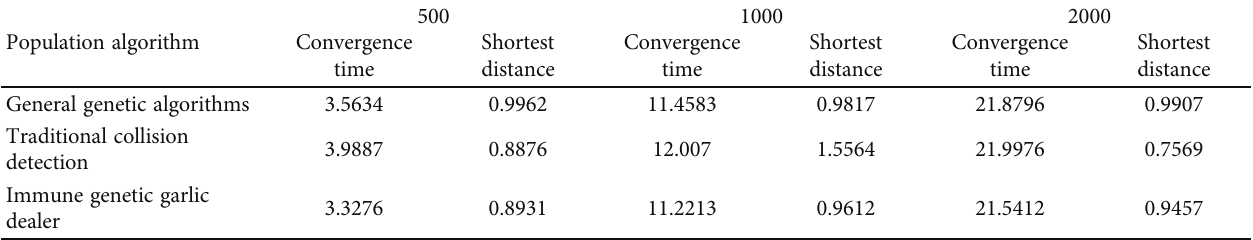
Table 3: The simulation results of the algorithm when the population is 500, 1000, and 2000.